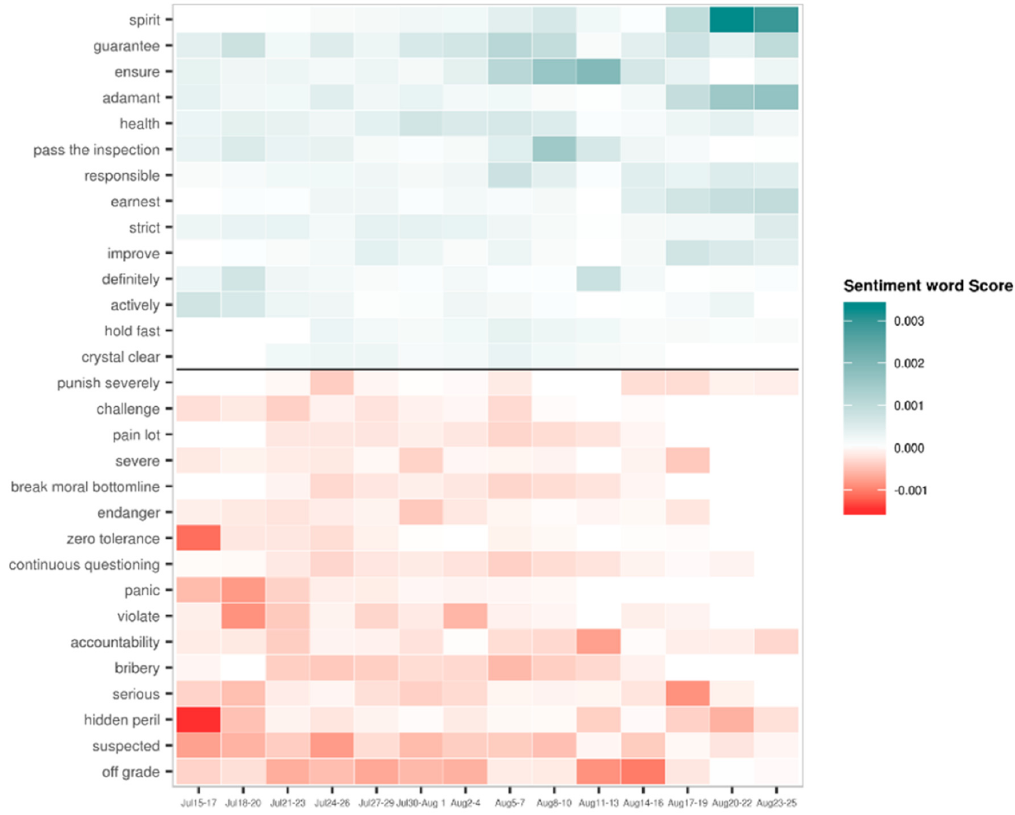
Figure 8. Temporal changes in the contribution of various sentiment words.